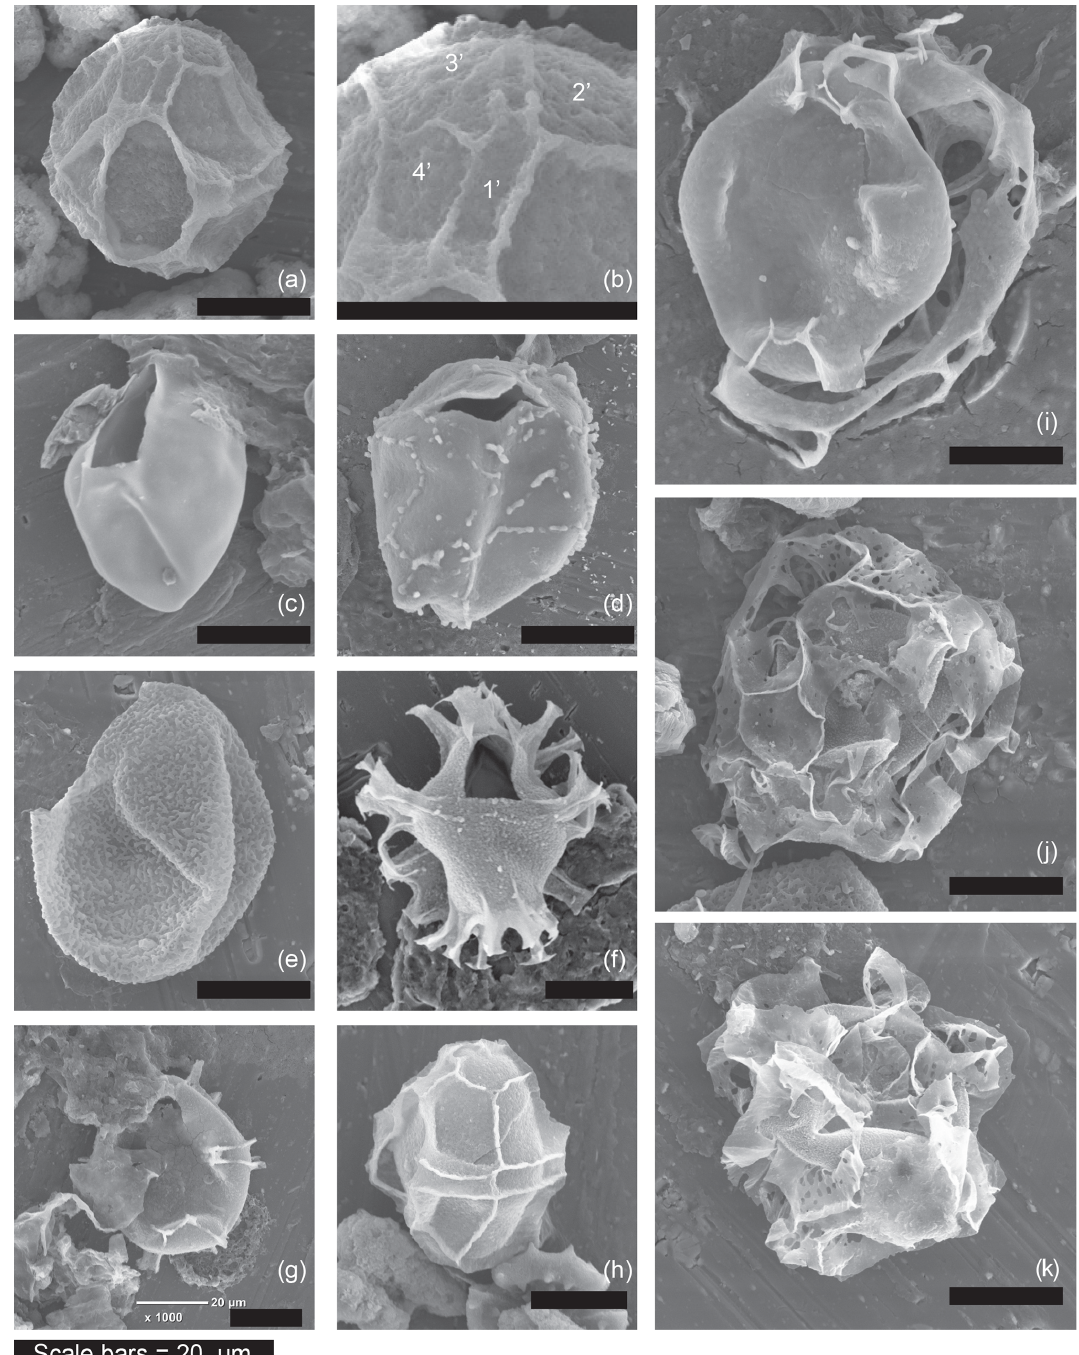
Figure 2. Examples of the morphotypes observed during the current study by scanning electron microscopy. Sample codes give core number (first number), section number (second number), depth within core (third number, in centimetres) and depth of the middle of the sample in metres below sea floor (mb.s.f.). (a) Impagidinium var. cruciform, refer to (b) for the close-up, which shows mismatch between plates 1 (cid:48) and 4 (cid:48) , (13-R-6-W 100–102.5cm, 120.41mb.s.f.). (b) Impagidinium var. cruciform (showing mismatch between plates 1 (cid:48) and 4 (cid:48) )